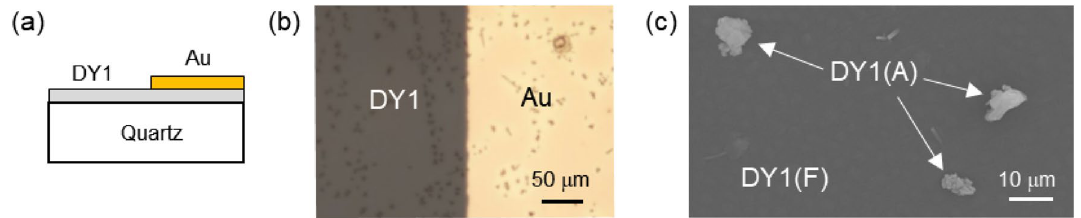
Figure 2. ( a ) Cross-sectional schematic diagram and ( b ) top-view optical microscope image of a DY1/quartz sample partially coated with a 60-nm Au thin film. ( c ) Aggregates with a lateral size of ~ 10 μm are clearly